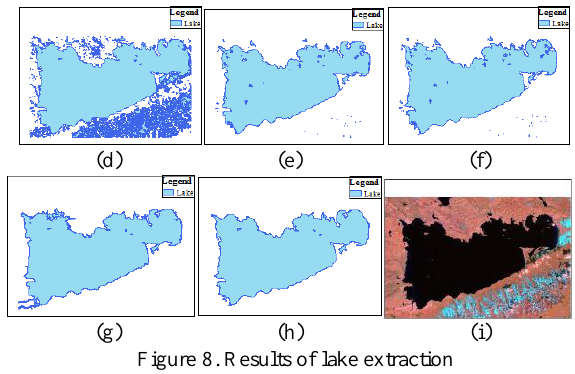
Figure 8. Results of lake extraction